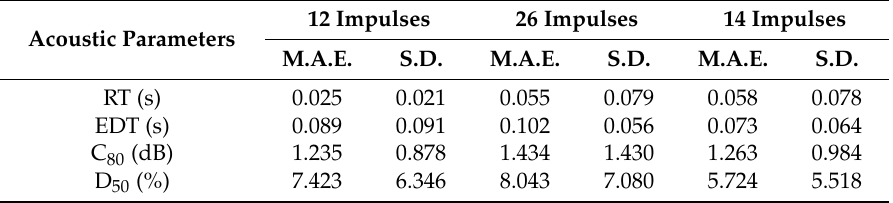
Figure 11. RT, EDT, C 80 and D 50 measured with different speaker placement methods. Table 3. Mean Absolute Error (M.A.E.) and Standard Deviation (S.D.) of RT, EDT, C 80 and D 50 for measurements with different speaker placement methods compared with measurements with the dodecahedron speaker.